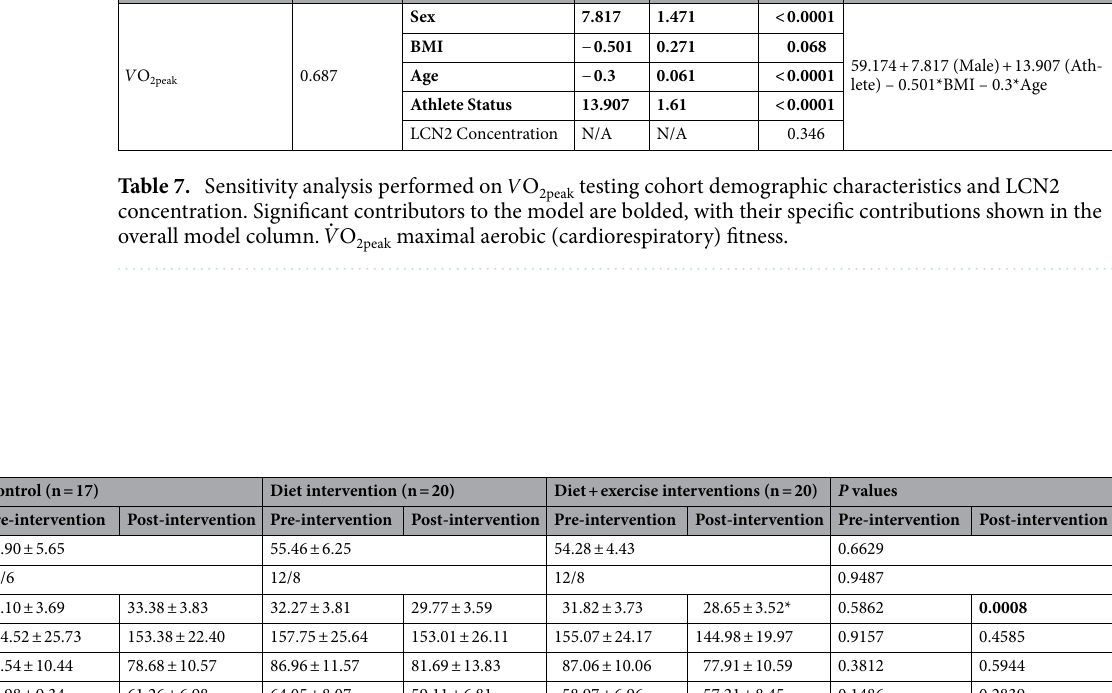
Table 8. Demographic and cardiovascular characteristics of intervention groups. Data are expressed as mean ± standard deviation from one-way ANOVAs comparing values between the three groups, with P values below 0.05 bolded. BMI, body mass index; SBP, systolic blood pressure; DBP, diastolic blood pressure; HR, resting heart rate. *Tukey’s honest significance test comparing BMIs from the control group to the diet and exercise intervention, resulting from a mixed ANOVA, with P = 0.04.